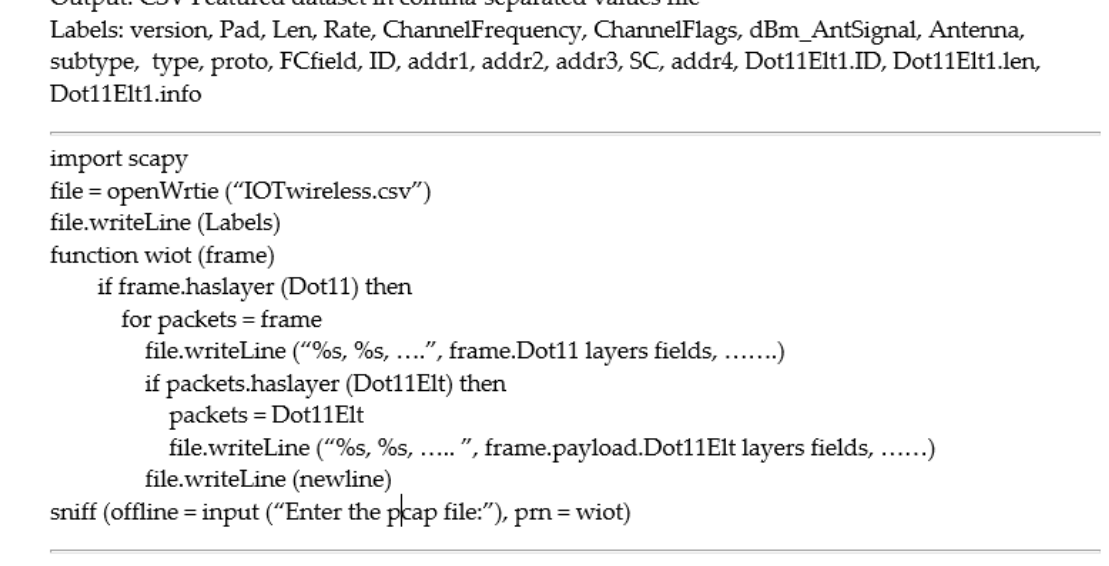
Figure 3. Algorithm 1 — feature extraction.